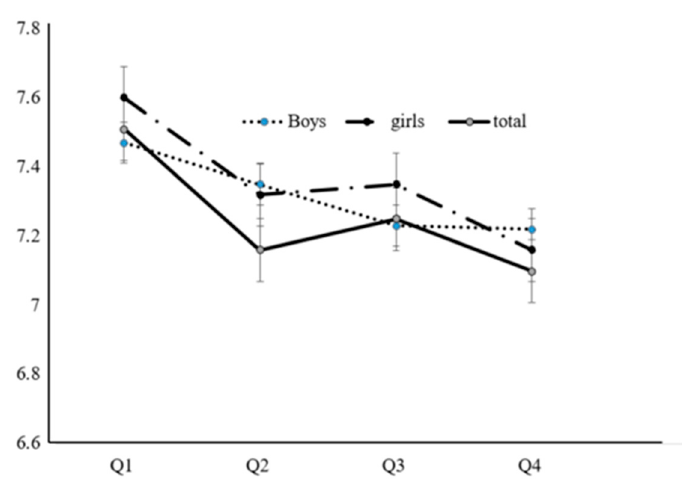
Figure 1. Adjusted sleep duration according to body mass index in both sexes. BMI: Body mass index. Adjusted for age, smoking, alcohol, physical activity, income, energy intake, each P value < 0.05. Q1: lowest BMI quartiles, Q2: middle–low BMI quartiles, Q3 middle–high BMI quartiles, Q4: highest BMI quartiles.